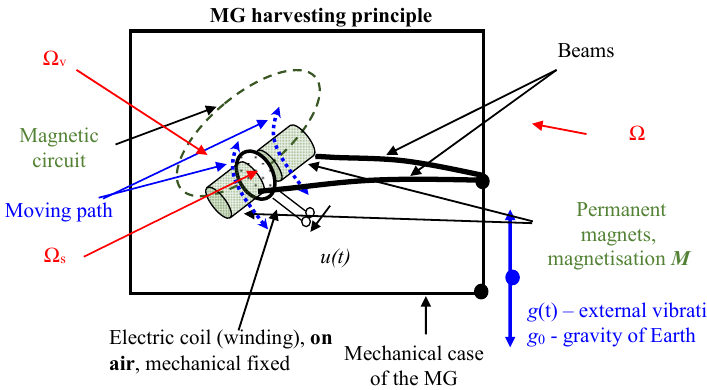
Figure 1. The principal configuration of the core of the minigenerator a beam version (BV).